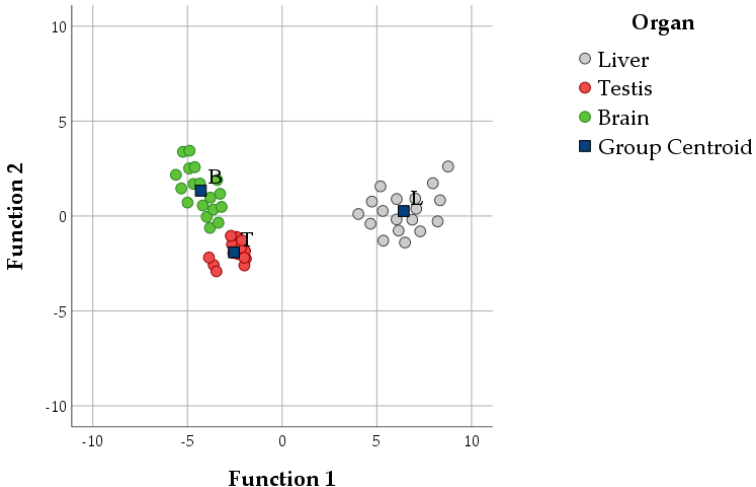
Figure 7. Scatterplot of canonical discrimination analysis (DA) including variables indicating antioxidant features (DA1) with the centroids of each organ (blue squares). L, liver; T, testis; B, brain. Table 4. Discriminant loadings of variables indicating lipids and isoprostanoids included in discri- minant analysis 2 (DA2) with percentage of variance, Wilks’s lambda, and the significance of each discriminant function.